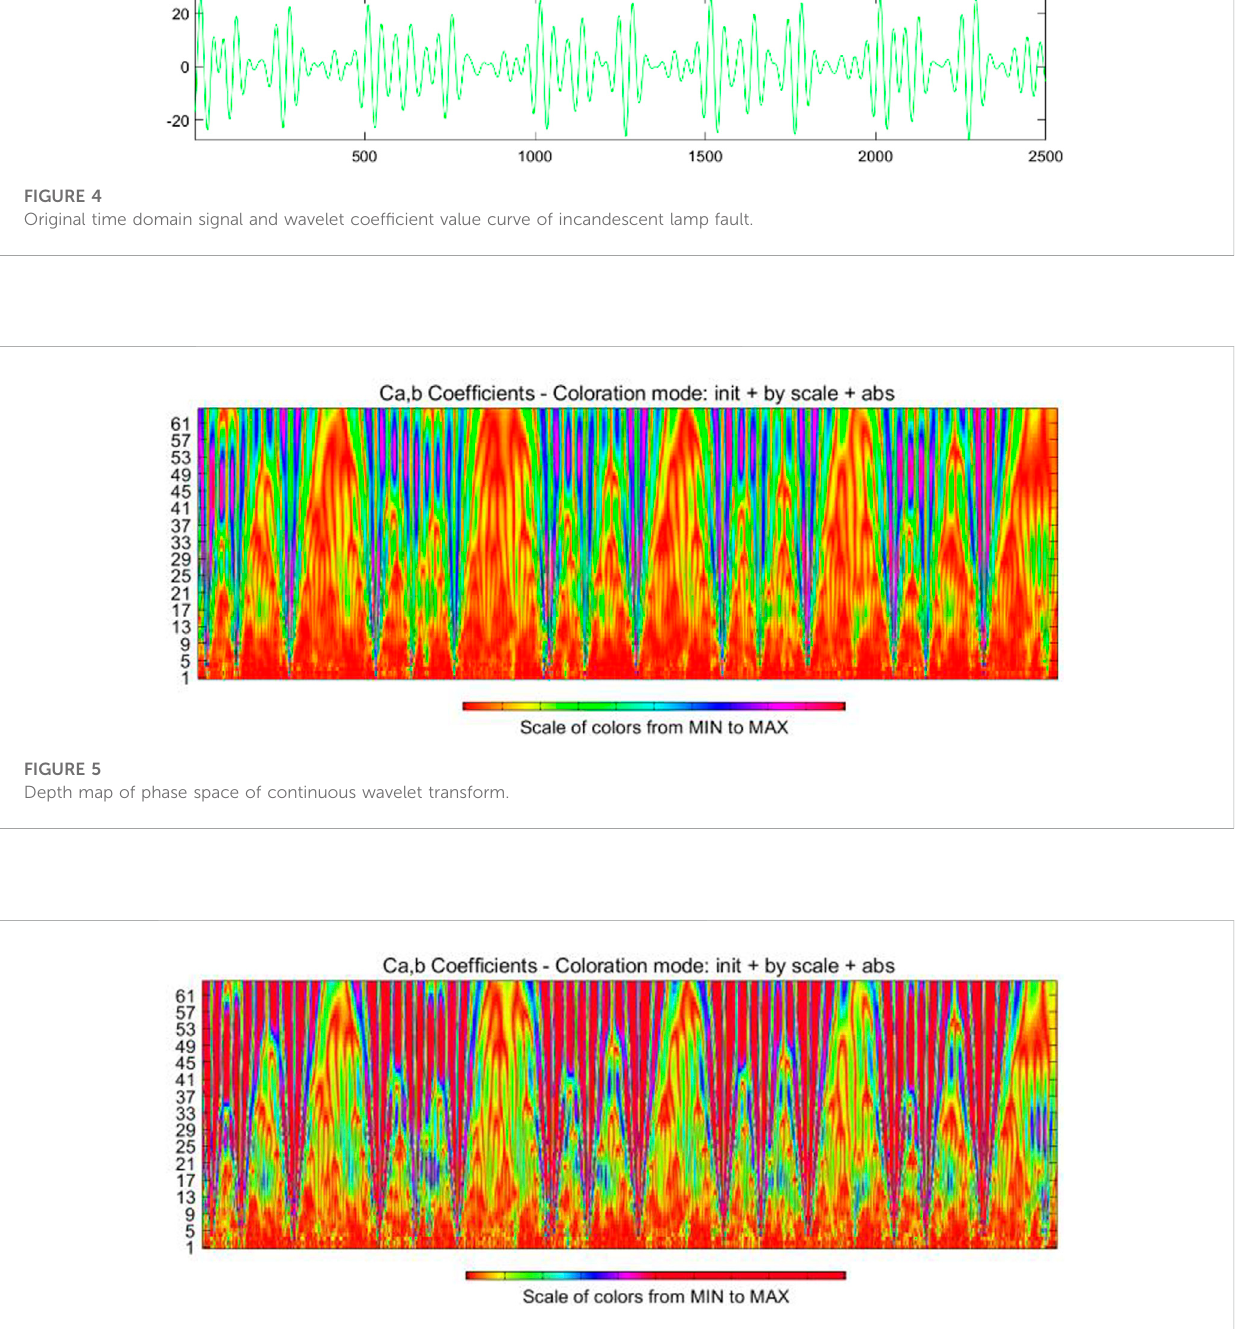
FIGURE 6 Phase space image of wavelet coef fi cients after changing color